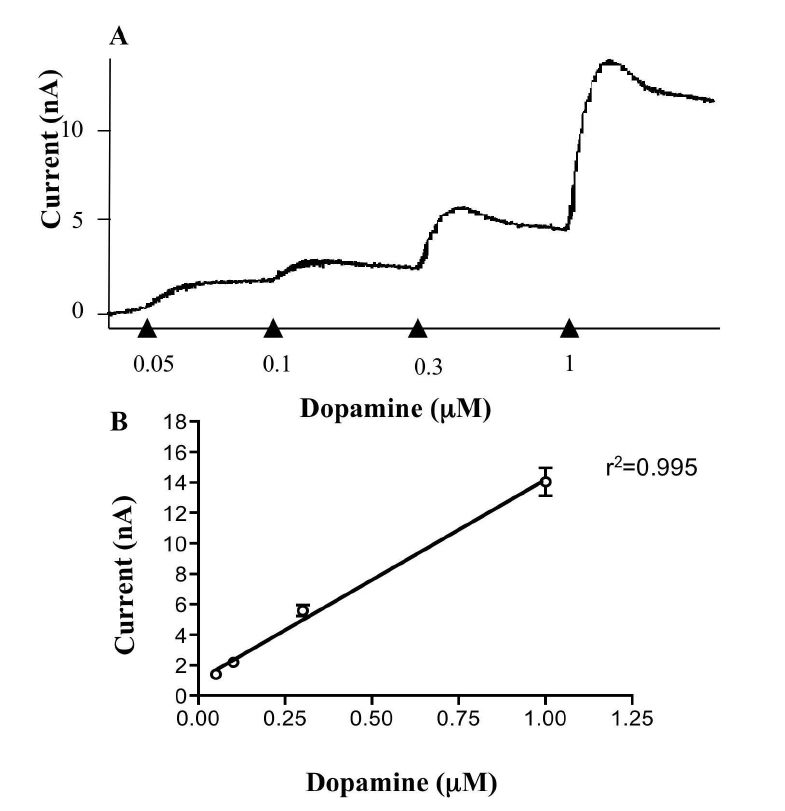
Figure 3. Calibration of the carbon fibre electrode Carbon fibre electrodes were routinely placed in known concentrations of freshly prepared dopamine after experiments in brain slices. A. Typical sample and hold output from an electrode after cumulative concentrations of dopamine were added (0.05 to 1 m M). The concentrations used are within the range of dopamine levels measured upon electrical stimulation in the striatum. B. Calibration curve showing the average of 20 carbon fibre electrodes. The relationship between dopamine concentration at the surface of the electrode and the measured current was found to be linear at these concentrations (r 2